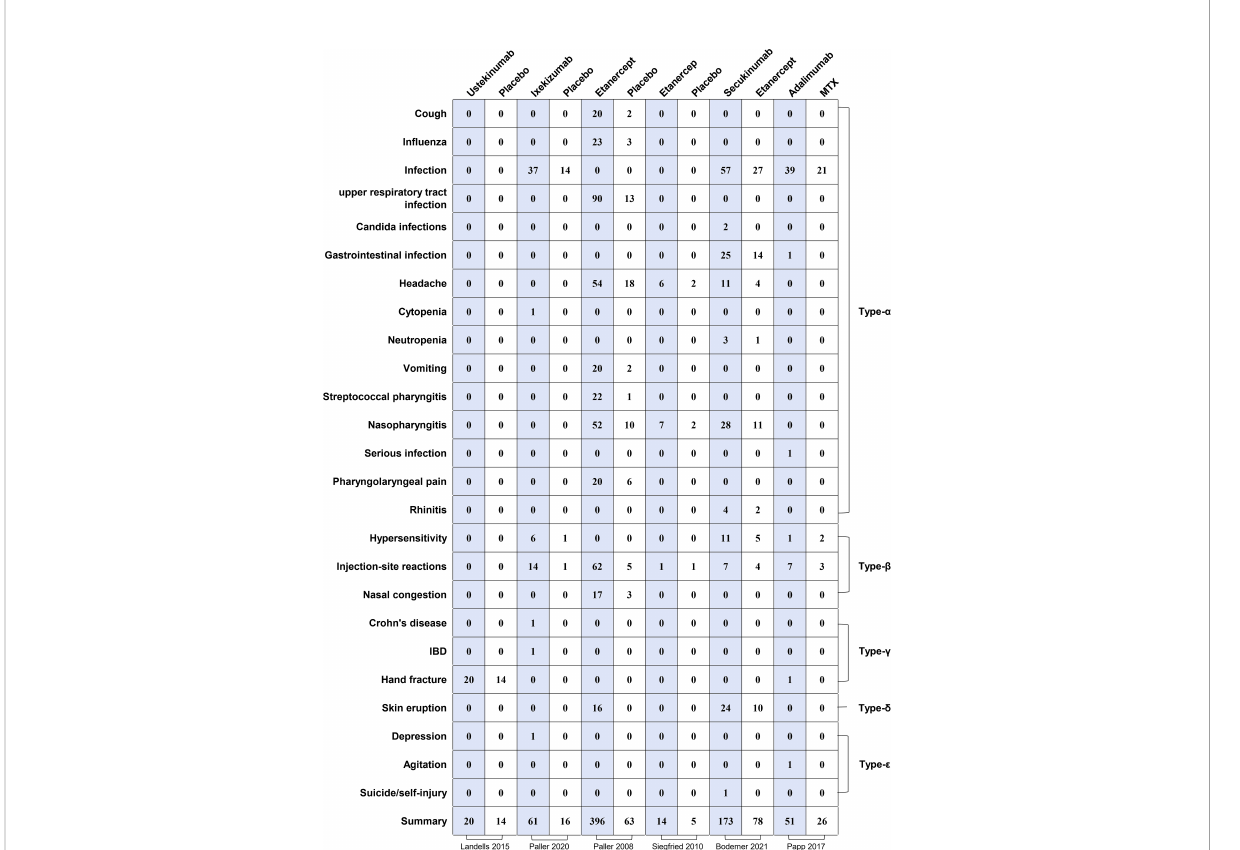
FIGURE 3 Mapping of speci fi c adverse events between biological agents and control groups. MTX: methotrexate. IBD: in fl ammatory bowel